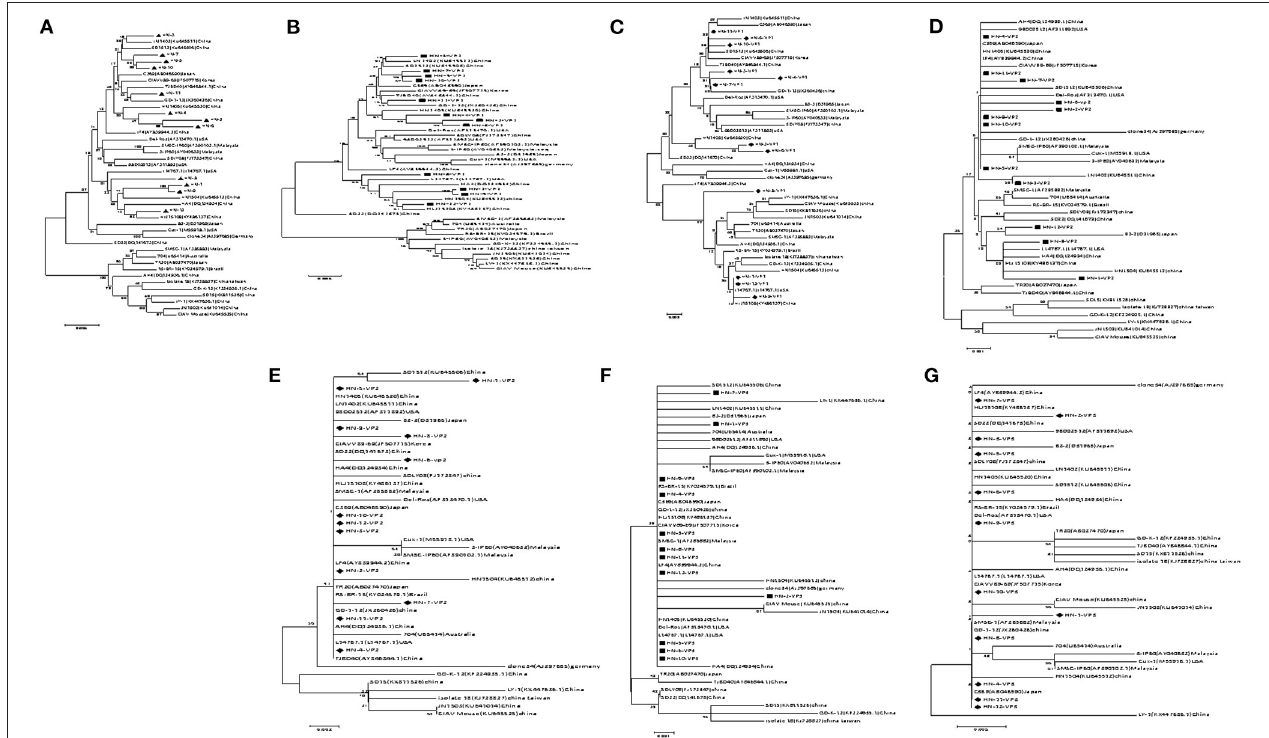
FIGURE 1 | Evolutionary tree analysis of (A) Whole genome sequence evolutionary tree analysis; (B) Nucleotides of VP1; (C) Amino acids of VP1; (D) Nucleotides of VP2; (E) Amino acids of VP2; (F) Nucleotides of VP3; (G) Amino acids of VP3.